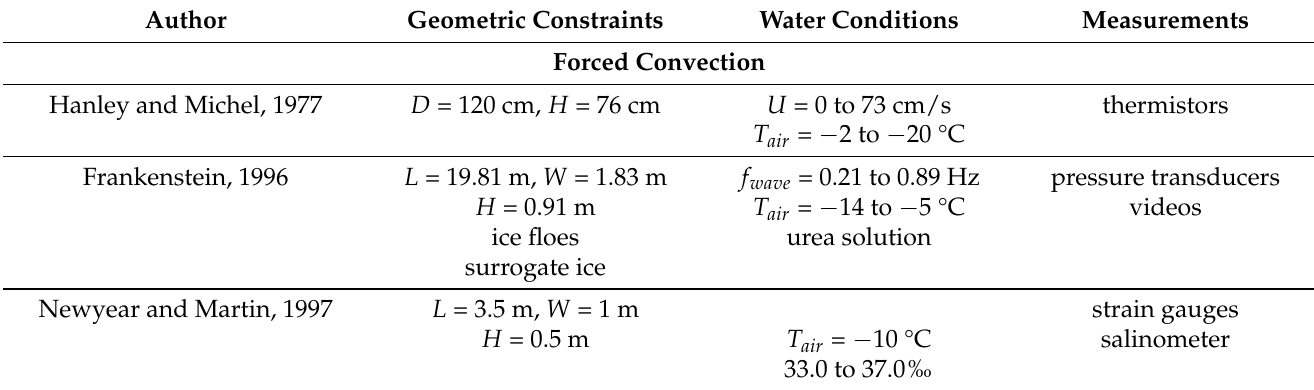
Table A6. Experiments focused on flow patterns and formation of pancake ice in forced